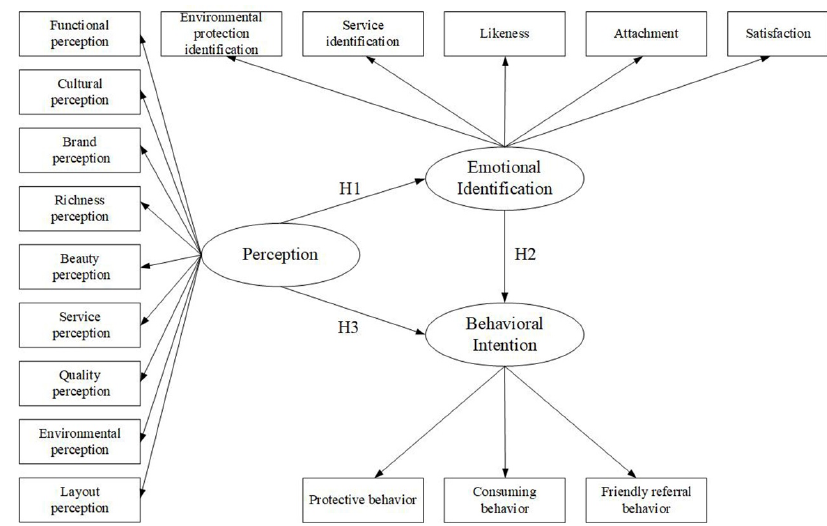
Figure 2. Hypothetical theoretical